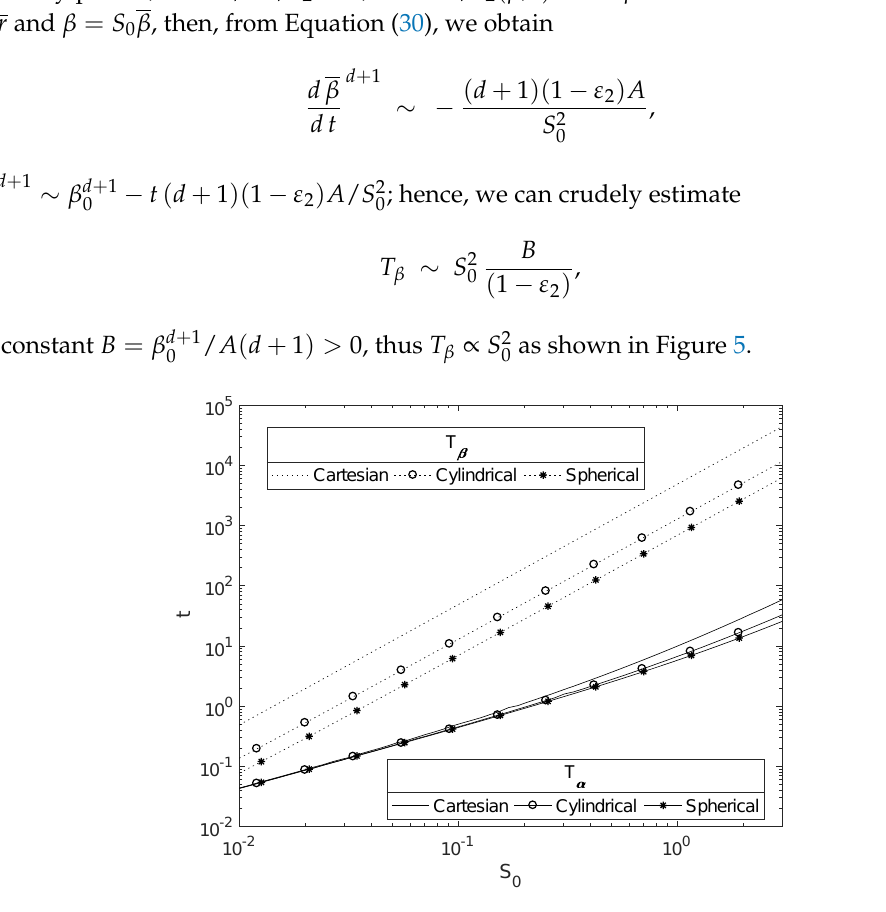
Figure 5. Plots of the dimensionsionless T α and T β against the initial magnesium block size, S 0 , for each of the principle geometries. The parameters used are ε 1 = 0.6, ε 2 = 0.4, κ ≈ 0.3 ( k = 0.5cm 4 /gday) and parameters in Table